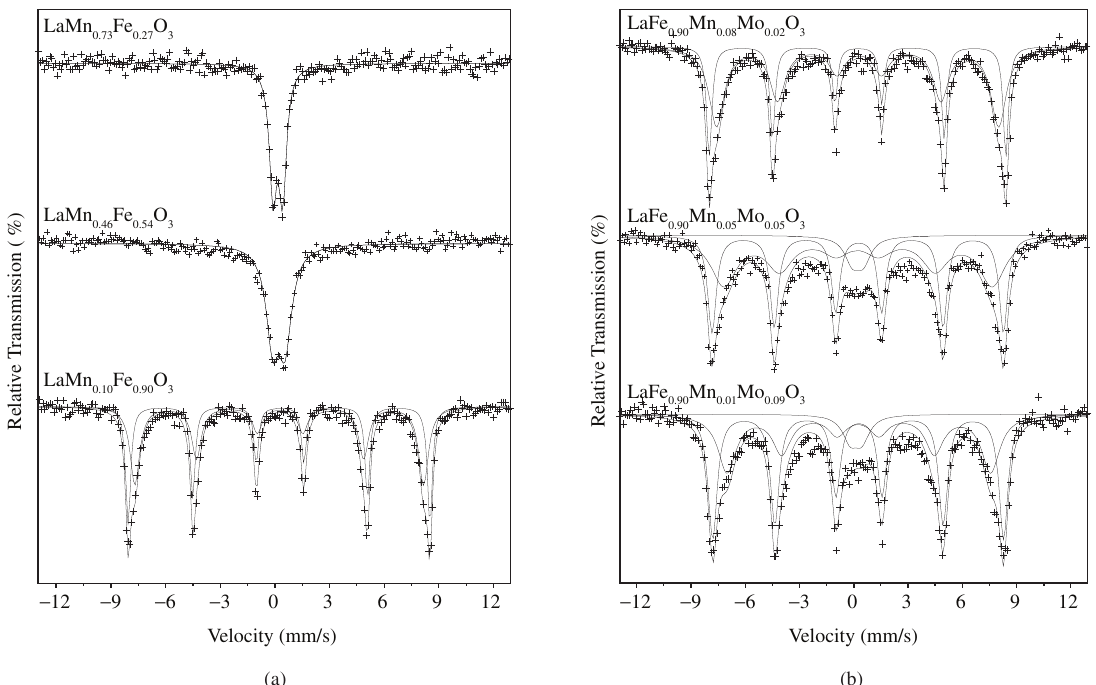
Figure 3. Room-temperature Mössbauer spectra of a) LaMn